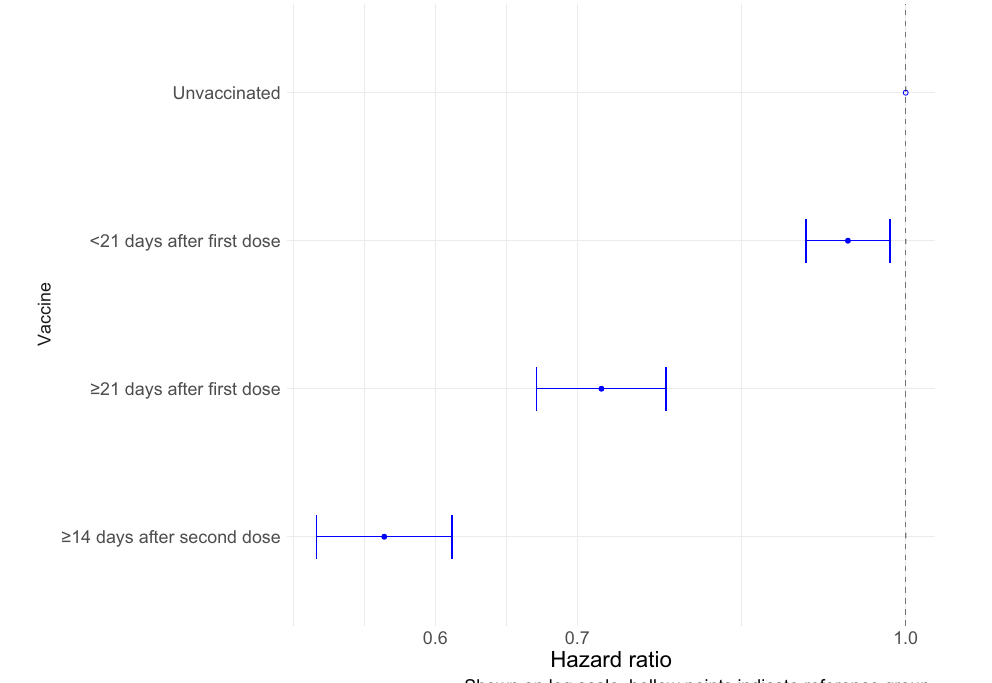
Hazard ratio Shown on log scale, hollow points indicate reference group. Referencegroup:Unvaccinated. n =126,679individualswithnecessaryinformation reported. Figure shows point estimate of hazard ratio with 95% con fi dence